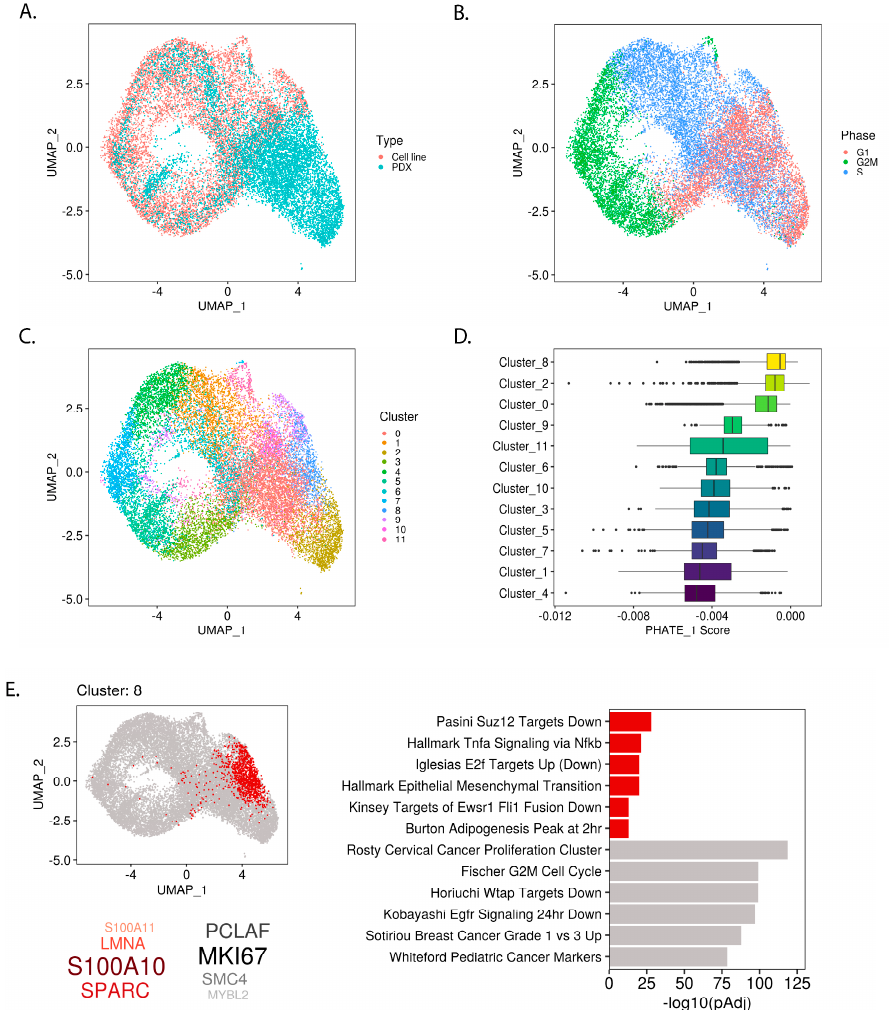
Figure 4. Mesodermal-like subpopulation within single-cell Ewing sarcoma transcriptomes revealed by PHATE_1 expression scores: ( A ) UMAP embedding of single-cell Ewing sarcoma transcriptomes in cell lines and patient-derived xenografts (PDXs) after alignment; ( B ) UMAP showing cell-cycle phase of each cell imputed from gene expression data and ( C ) Louvain clustering assignments; ( D ) Box-plot showing the PHATE_1 expression scores for each sample in each cluster, organized by median score; ( E ) Cluster marker analysis of cluster 8 shows location within UMAP embedding, the top positive marker genes (red) and negative marker genes (grey), and top enriched pathways (with the “integrated” gene set collection) in positive and negative marker genes (red and grey respectively).